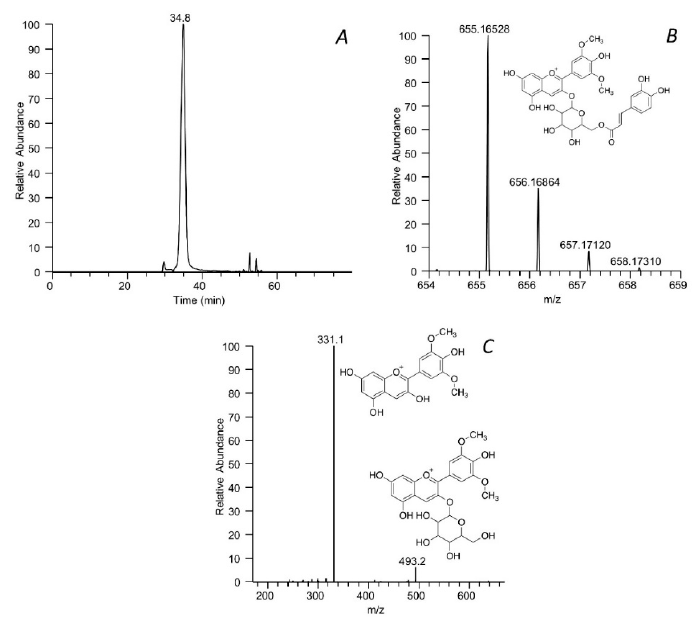
Figure 2. LC-ESI-MS/MS identification of malvidin 3-O-(6”-caffeoyl)-glucoside. Chromatographic peak at 34.8 min ( A ), isotopic ( B ), and fragmentation ( C ) pattern.